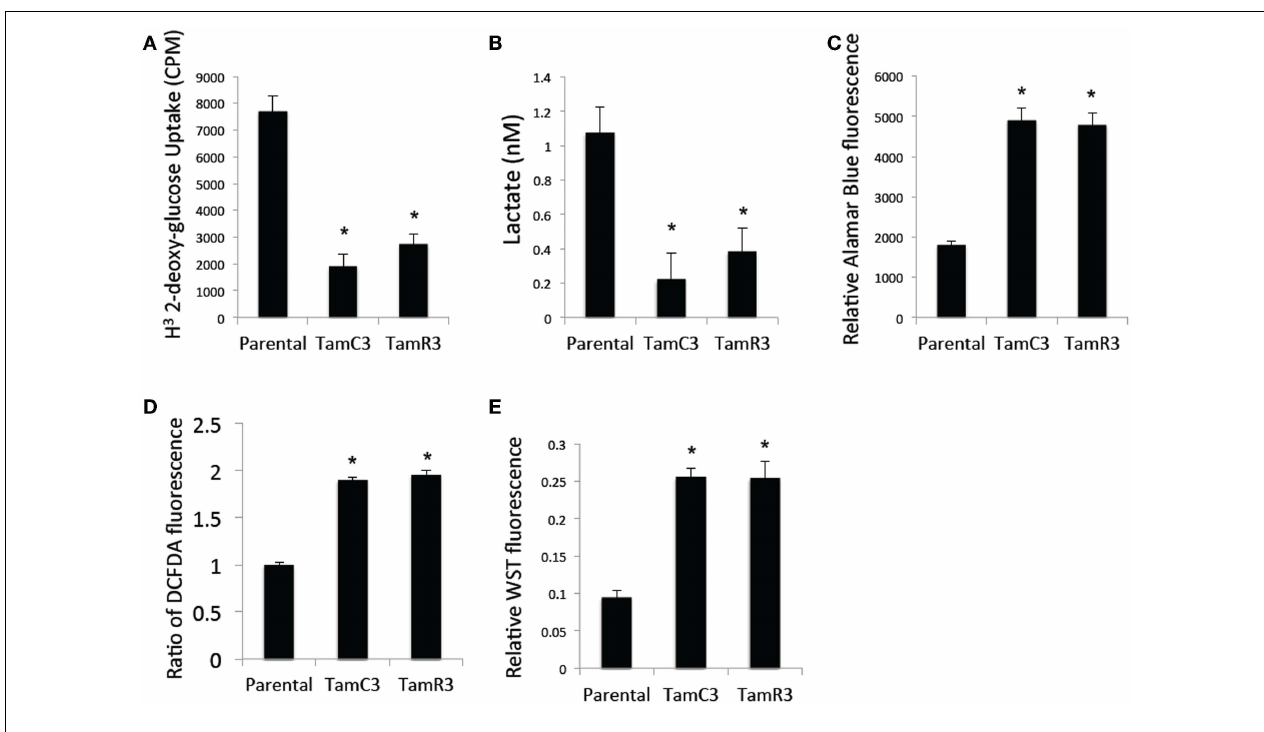
cells as measured by DCF-DA fluorescence. (E) SOD activity in MCF-7 parental,TamC3, andTamR3 cells, as measured byWST assay. *Significantly different from MCF-7 parental line ( p < 0.05). Results from representative experiments were shown as the mean ± SE from the indicated replicates detailed in the Section “Materials and Methods.”